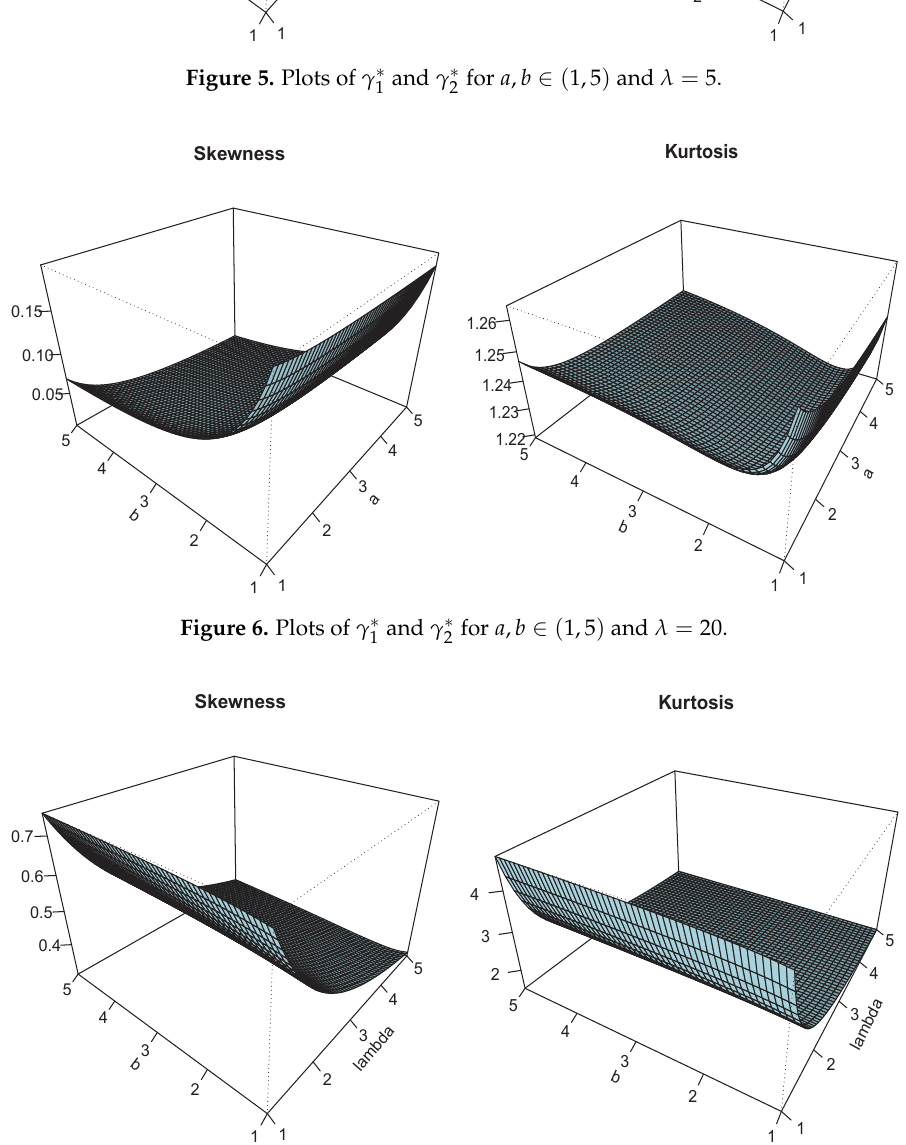
and γ ∗ for λ , b ∈ ( 1,5 ) and a = 2 1